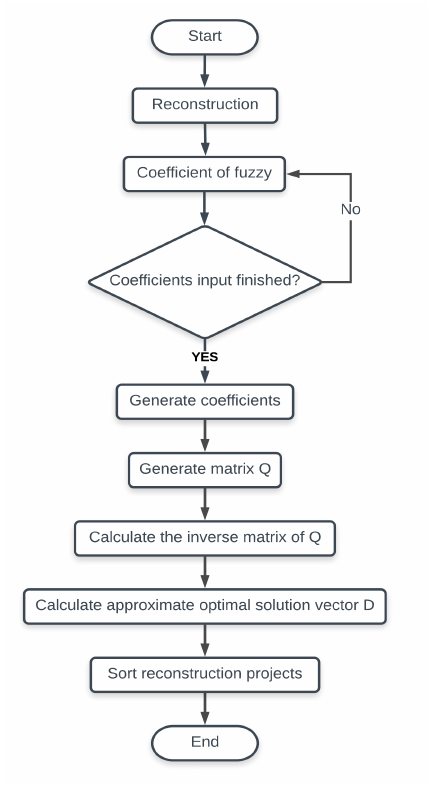
Figure 2. Flowchart of the ranking